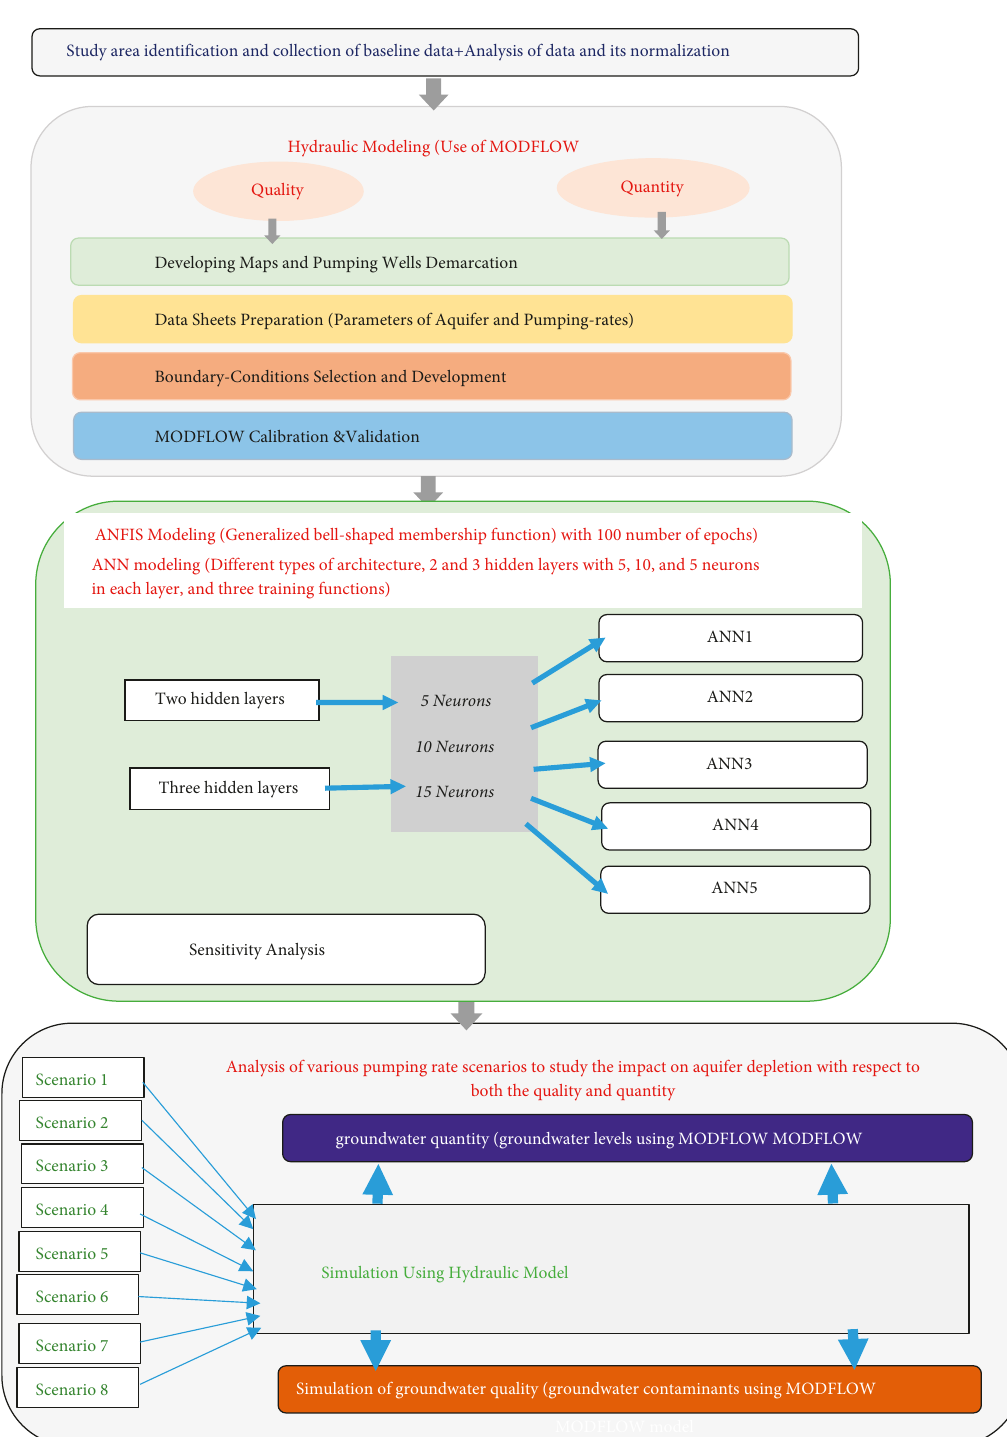
Figure 2: Groundwater modelling framework to explore the impacts of pumping on depletion of aquifer. The data for pumping rates, groundwater levels, and conceptual comparison of the two techniques is given in concentration of contaminants have been normalized in the Table 1. An overall methodology framework is shown in case of ANFIS and ANN models. The second step was to Figure 2. Three main steps are involved in this research calibrate/train/test/validate as per the requirement of both work. The first step comprised data collection, including categories of models (hydraulic/ANFIS andANN). Part of pumping rates, groundwater levels, well locations, the the data (say 60%) was used for calibration/training, and the concentration of contaminants, and parameters of the